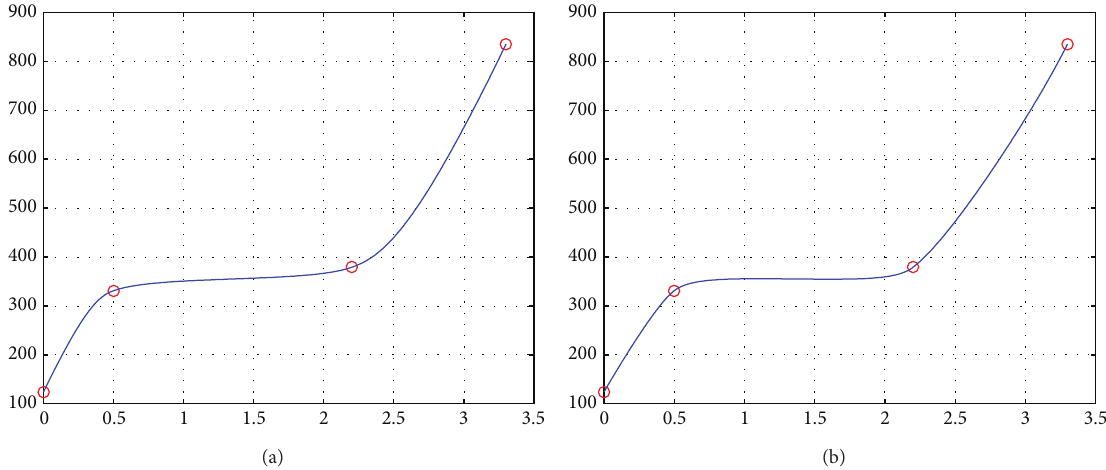
Figure 9: Comparison between our monotonicity-preserving interpolation spline curves (on the left) and the monotonicity-preserving interpolation spline curves given in [26].